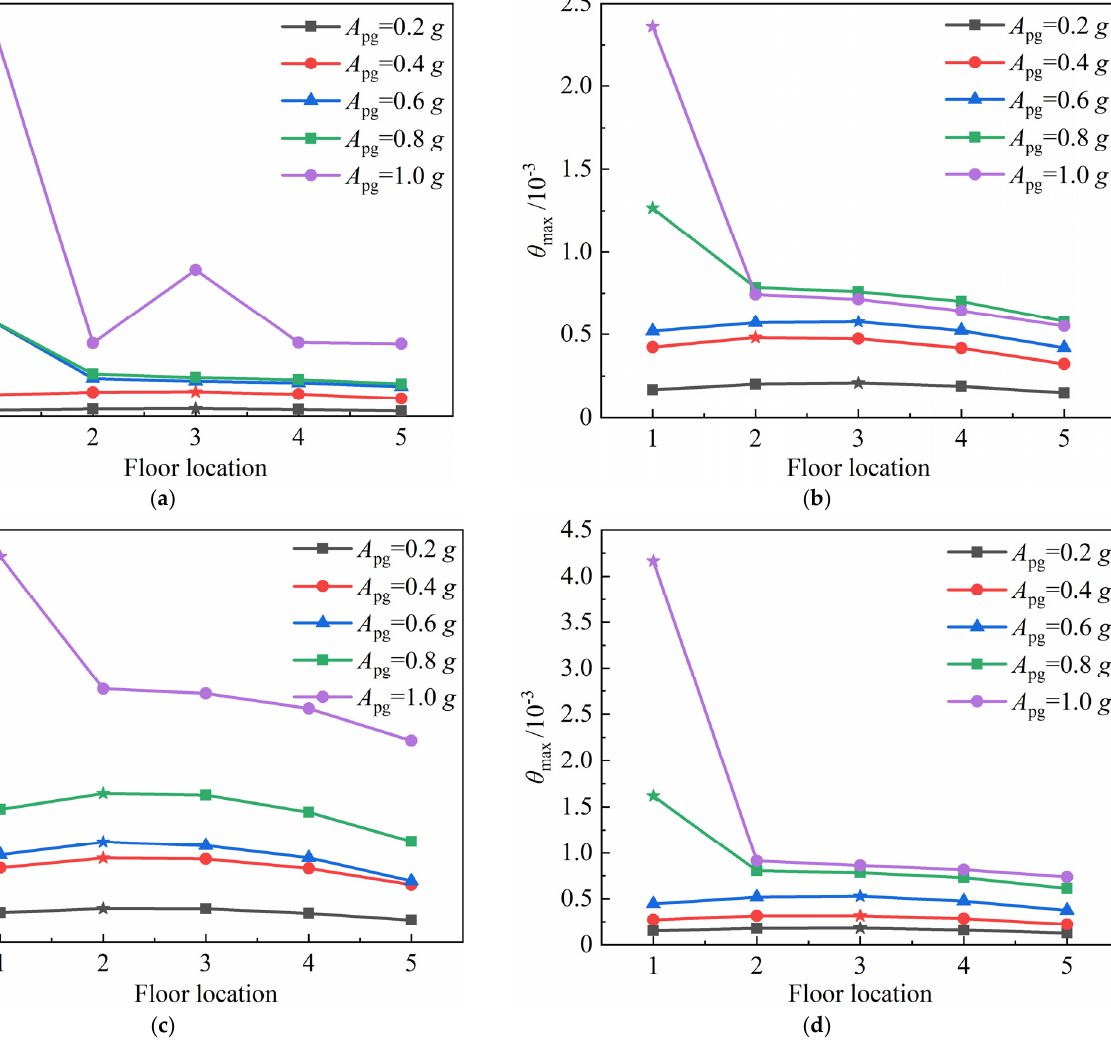
Figure 12. Inter-story displacement angle under 4 groups ground motion records: ( a ) DLT352; ( b ) CAP000; ( c ) MUL279; ( d ) CHY101E.